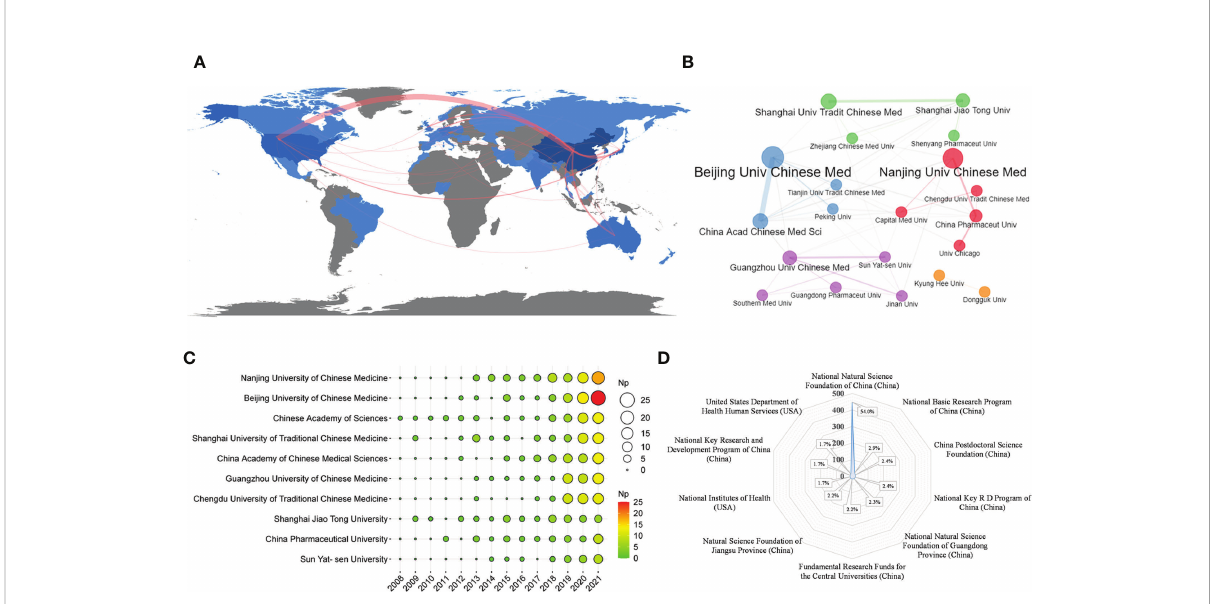
FIGURE 3 (A) Country scienti fi c production and international collaboration network in TCM/GM (the red line represents the collaboration network between countries, the thickness of the line represents the strength of collaboration). (B) Collaboration network of the top 20 corresponding institutions in TCM/GM. (C) Annual scienti fi c production of the top 10 most productive institutions over time in TCM/CM based on WoS (the size of the circle represents the number of publications, and the larger the circle, the more the number of publications). (D) The top 10 funding agencies in the support of TCM/GM